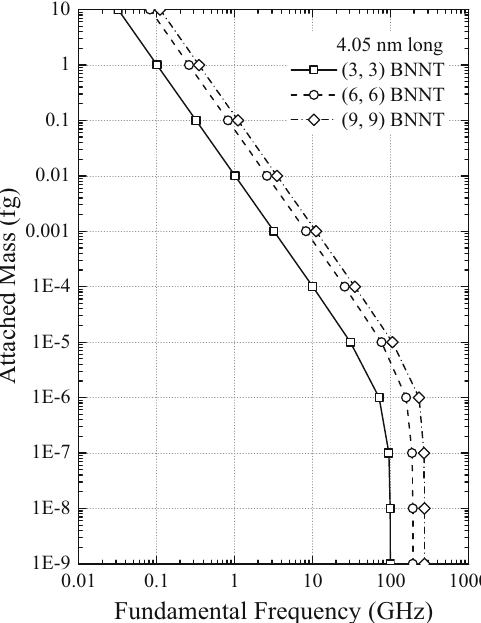
Figure 3: Resonant frequencies for ( 3,3 ) , ( 6,6 ) , and ( 9,9 ) cantilevered SW - BNNT with length 4.05nm for di ff erent attached masses.